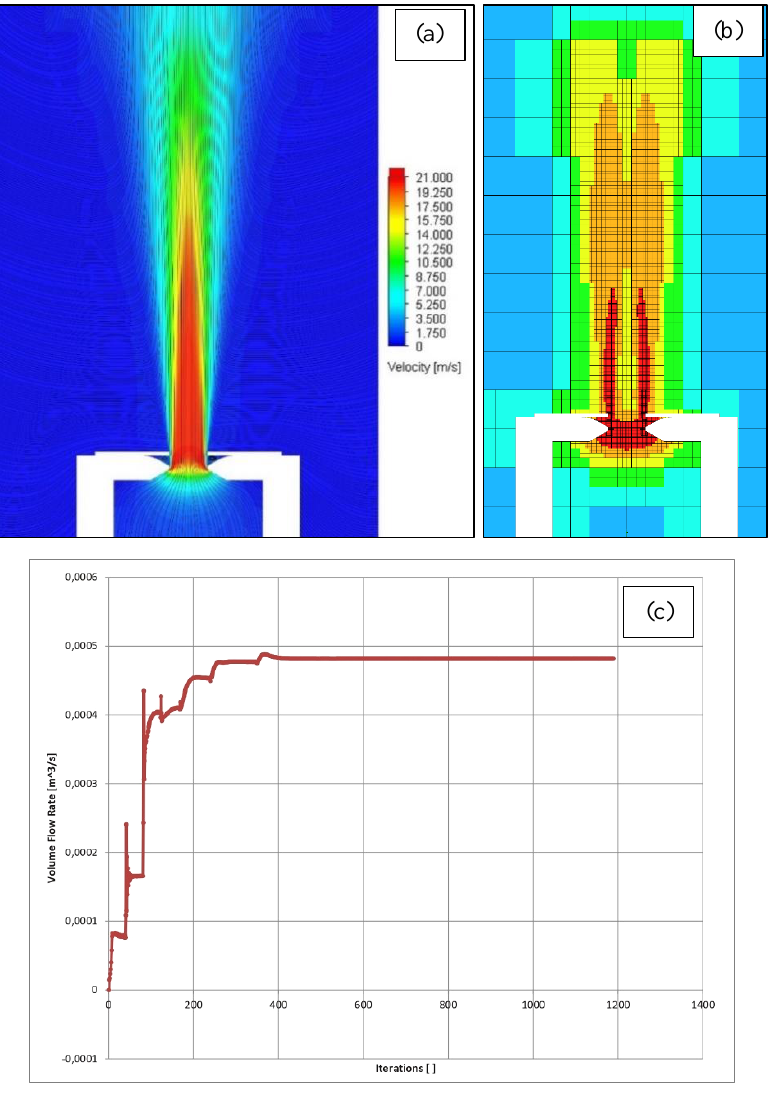
Figure 27. Liquid outflow pattern from a nozzle with a diaphragm for conditions when ∝ =0 o : (a) Calculation data; (b) A fragment of the adapted computational grid; (с) A fragment of the report on the calculation data convergence. Calculation parameters: total number of cells in the computational grid 320911; computation time 14404 с; the number of iterations